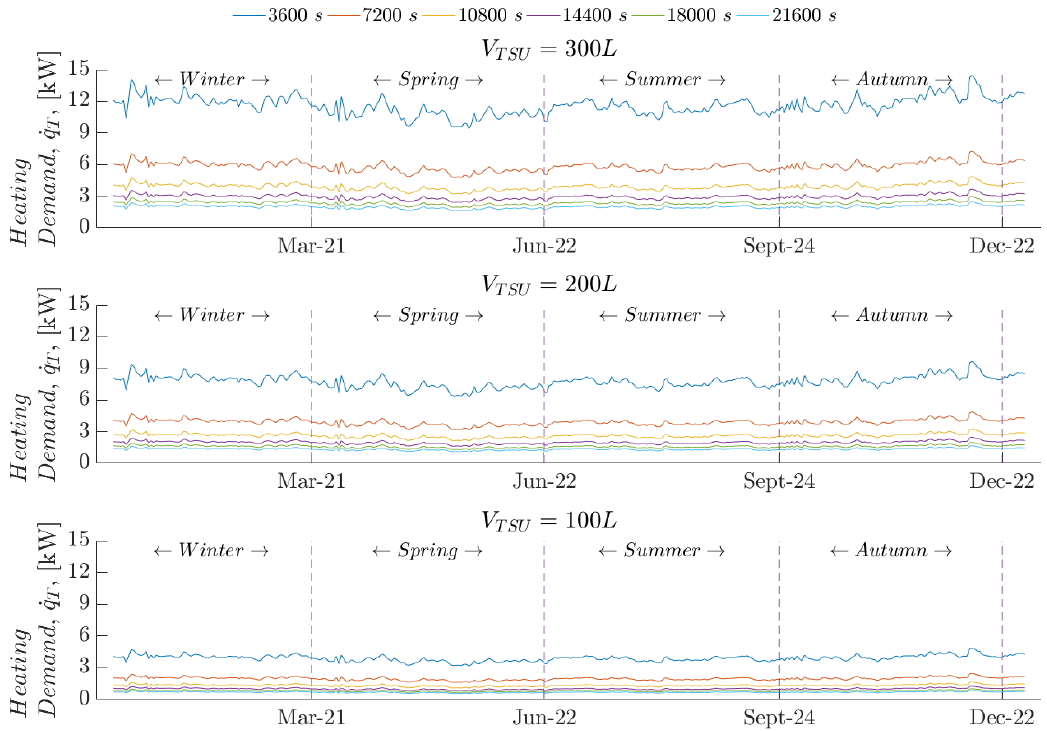
Figure 11. Energy demand throughout the year for all water loads.